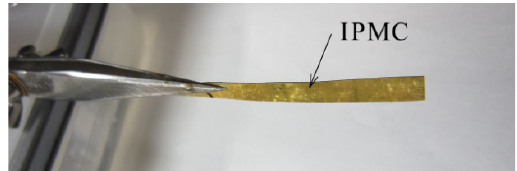
Figure 1. Ionic polymer metal composite (IPMC).